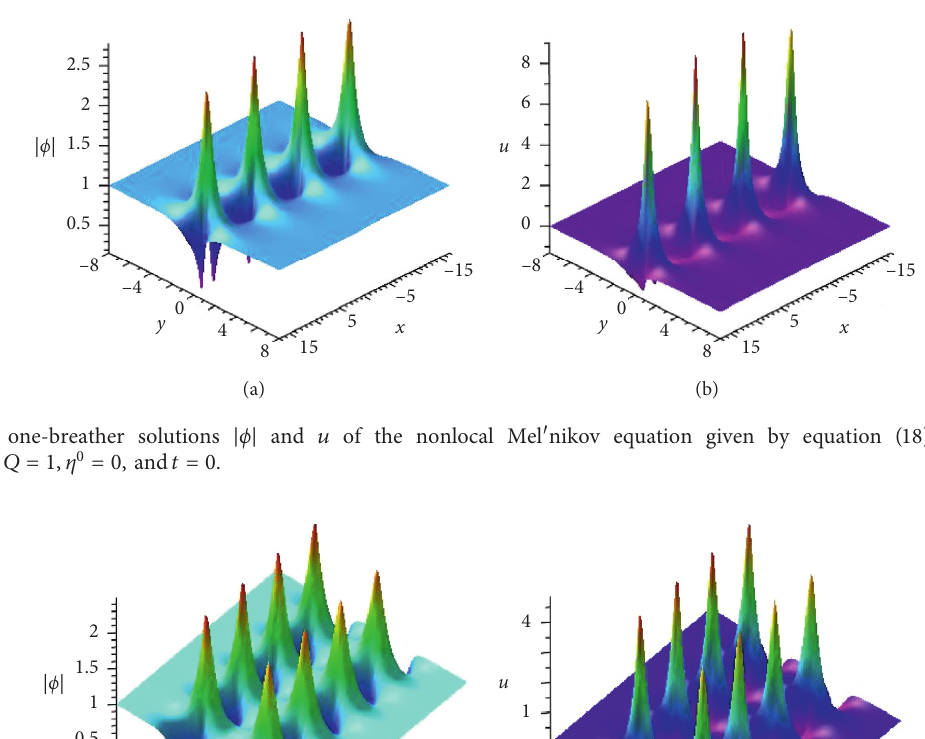
� 1 ,P � − 1 , P � 1 , 1 2 3